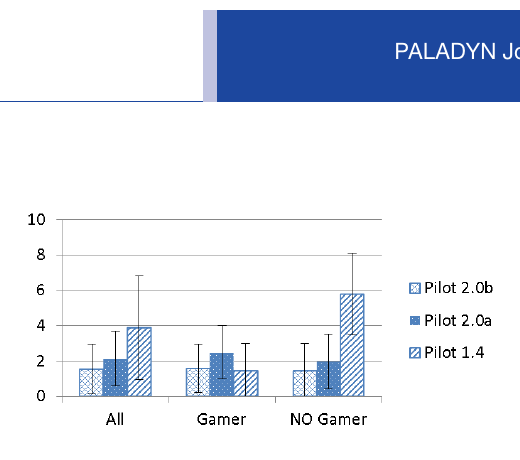
Figure 10. Performance in terms of collisions (means and SDs for differen groups of users).